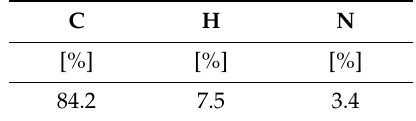
Table 3. Elemental analysis of the produced macroporous base